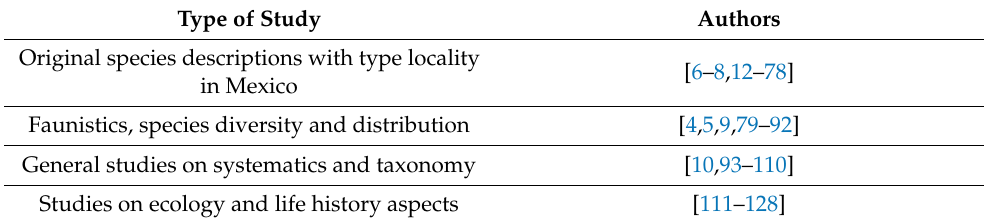
Table 1. Relevant work on the Neuroptera fauna of